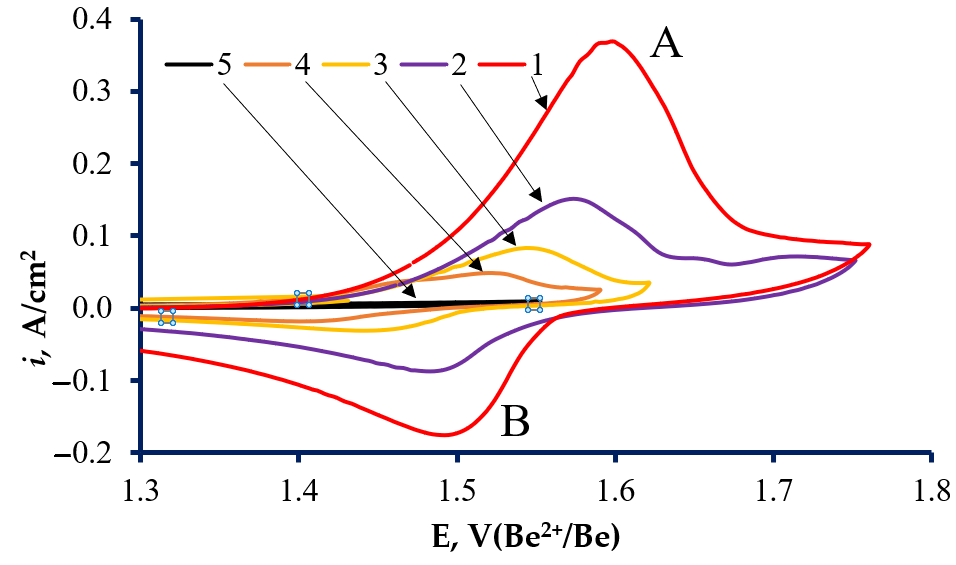
Figure 3. Cyclic voltammograms in the 0.66LiF–0.34BeF 2 –FeF 2 melt at T = 923 K and iron concentra- tions, wt.%: 1 — 0.0992; 2 — 0.0651; 3 — 0.0551; 4 — 0.0338; 5 — 0.0031.